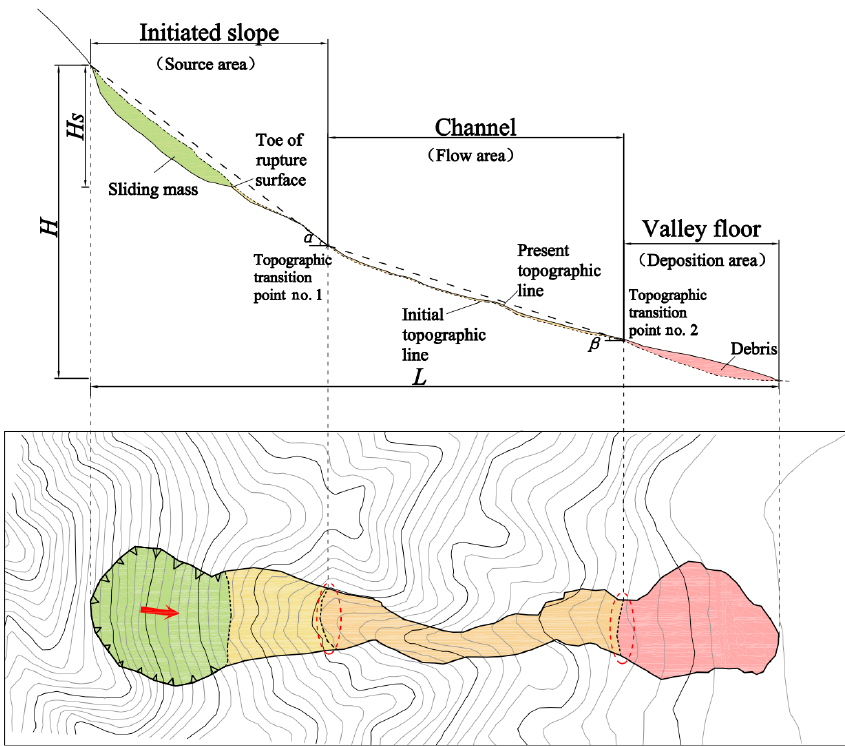
Figure 3. Sketch map of a channelized rock avalanche defining geometric parameters. The red-dashed ellipse indicates the topographic transition dividing the initiated slope, channel and valley floor. The red arrow represents sliding direction of source mass.